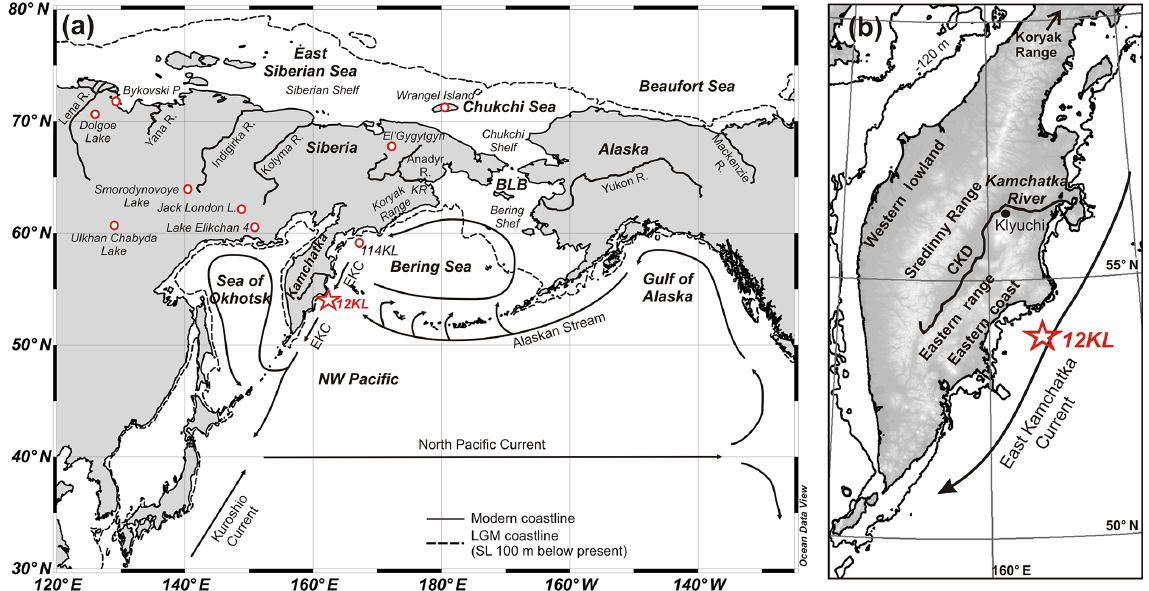
Figure 1. (a) Overview of Beringia and the N Pacific. Site SO201-2-12KL is marked by a red star. Circles represent sites mentioned in the text. Black arrows indicate the surface circulation patterns of the N Pacific (e.g., Stabeno and Reed, 1994). BLB is Bering Land Bridge, KR is Kankaren Range, R is river, EKC is East Kamchatka Current, P is peninsula and L is lake. (b) Map of the Kamchatka Peninsula and its major orographic units. CKD is Central Kamchatka